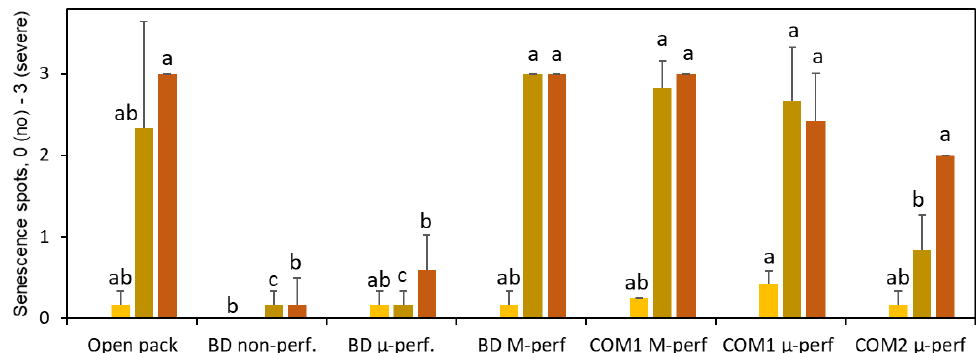
Figure 6. The effect of packaging methods on the severity of banana peel discoloration (senescence spotting) after 3 days of simulated distribution at 15 °C and 1, 3 or 5 days of shelf life/home storage at 24 °C. Package designations are the same as in Figure 2. Error bars represent standard errors of three replications. Within each sampling day, different letters above the bars indicate significant differences between packaging types at p ≤ 0.05, according to Tukey’s HSD test.